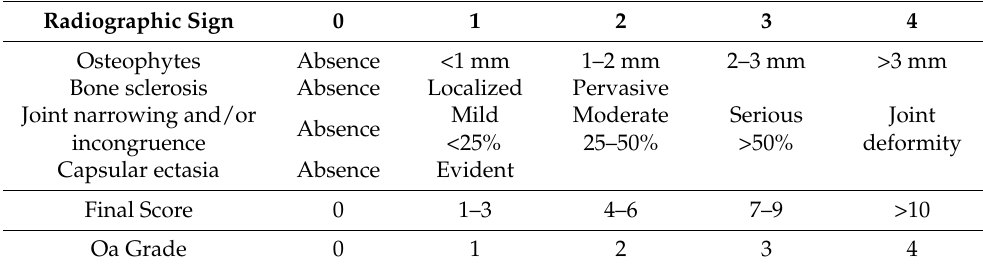
Table 3. Radiographic modified scale of